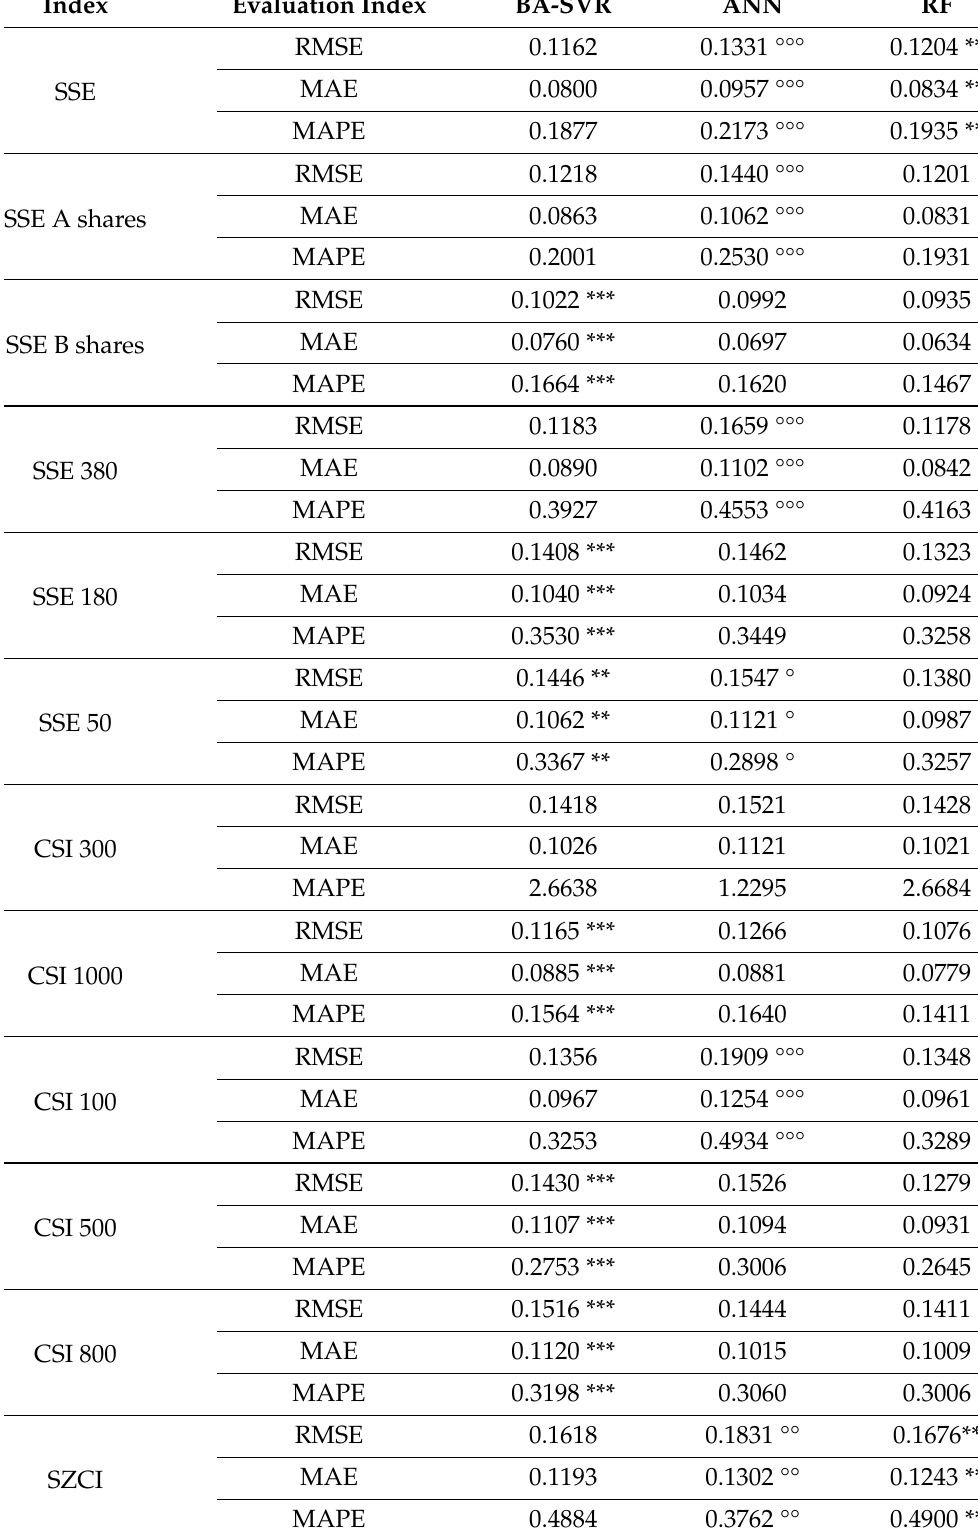
Table 17. The 250-day long-term forecast effect of 18 stock